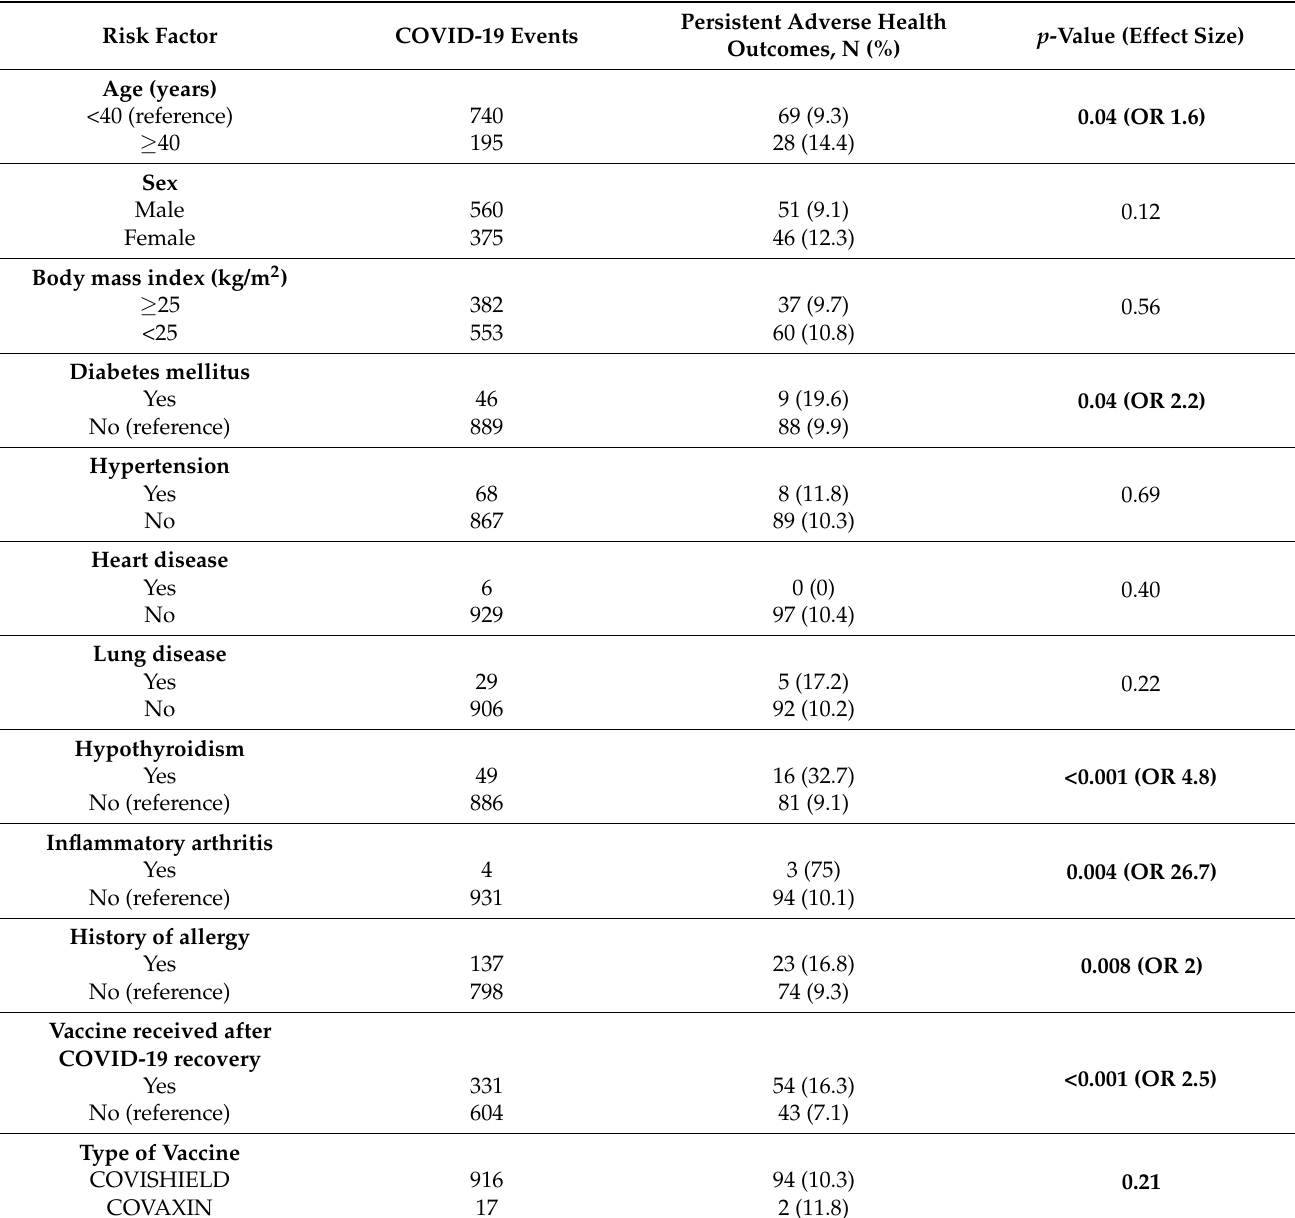
Table 3. Bivariate analysis to determine risk factors for persisting health issues in health care workers ( n = 935 COVID-19 events) with history of COVID-19 vaccination before or after COVID-19